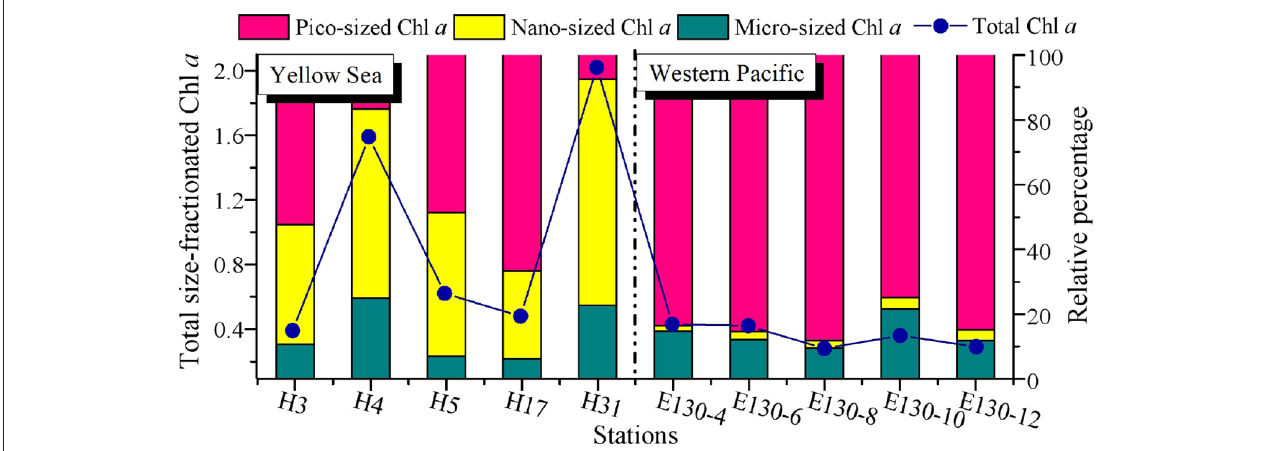
FIGURE 2 | Spatial variations of total size-fractionated Chl a concentrations ( µ g L − 1 ) and the relative proportion (%) for each size class among sampling stations in the Yellow Sea and the Western Pacific. Blue dots and lines denote the total size-fractionated Chl a concentrations, which were the sum of the three size classes. Note that all the size-fractionated Chl a data were expressed as depth-weighted averages, corresponding to the y -axis on the